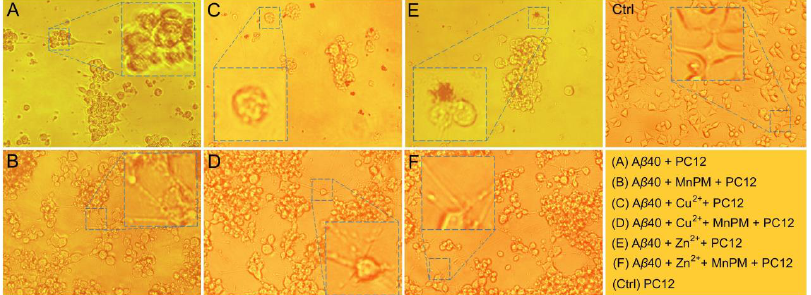
Figure 10. Photomicrographs microscopy images of PC12 cells after incubation with Zn 2+ - or Cu 2+ -induced A β 40 aggregates with or without MnPM (A β 40 = 20 μ M, MnPM = 20 μ M, [Cu 2+ ] = [Zn 2+ ] = 40 μ M) (inset: partial enlarged detail. All the samples with final DMSO content: volume ratio 0.5%) .